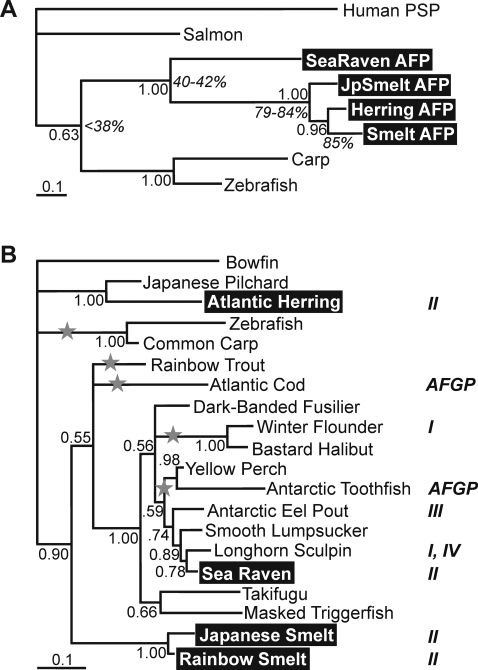
Phylogenetic trees of AFPs and related lectins as well as selected teleost fishes.(A) Bayesian 50% majority rule consensus tree (from 7500 sampled trees) based on the protein sequences aligned in Figure 2. The alignment was truncated to the beginning of the first helix (α0) to the end of the sea raven sequence. Branch lengths represent the expected fraction of changes, and Bayesian posterior probabilities above 50% and selected percent identities (italics) are indicated near the nodes. The highest identity between the AFPs and any other C-type lectin domain is 38%. Herring AFP is 84% and 85% identical to Japanese and rainbow smelt AFPs, respectively. The two smelt sequences share 79% identity. (b) Phylogenetic tree of teleosts based on ribosomal 16S RNA sequence comparison. Species are referred to by their common names. Those that are known to produce AFPs have the type of AFP they produce indicated alongside (AFGP, antifreeze glycoprotein; I, alanine-rich alpha-helical; II, lectin-like; III, beta-clip fold; IV, helix bundle). Those that produce type II AFP are highlighted. The rainbow smelt and herring sequences were double-checked by amplification from the DNAs used in this study and were almost identical to the sequences reported in the database. The non-teleost fish, the bowfin, was used to root the tree and only posterior probabilities >50% are shown. Putative type II gene loses (presuming the presence of the gene in the common ancestor) are indicated by grey stars. A further gene loss on the Takifugu/masked triggerfish lineage is not postulated since these fish group with yellow perch and Antarctic toothfish according to the phylogeny of Miya et al. [22].